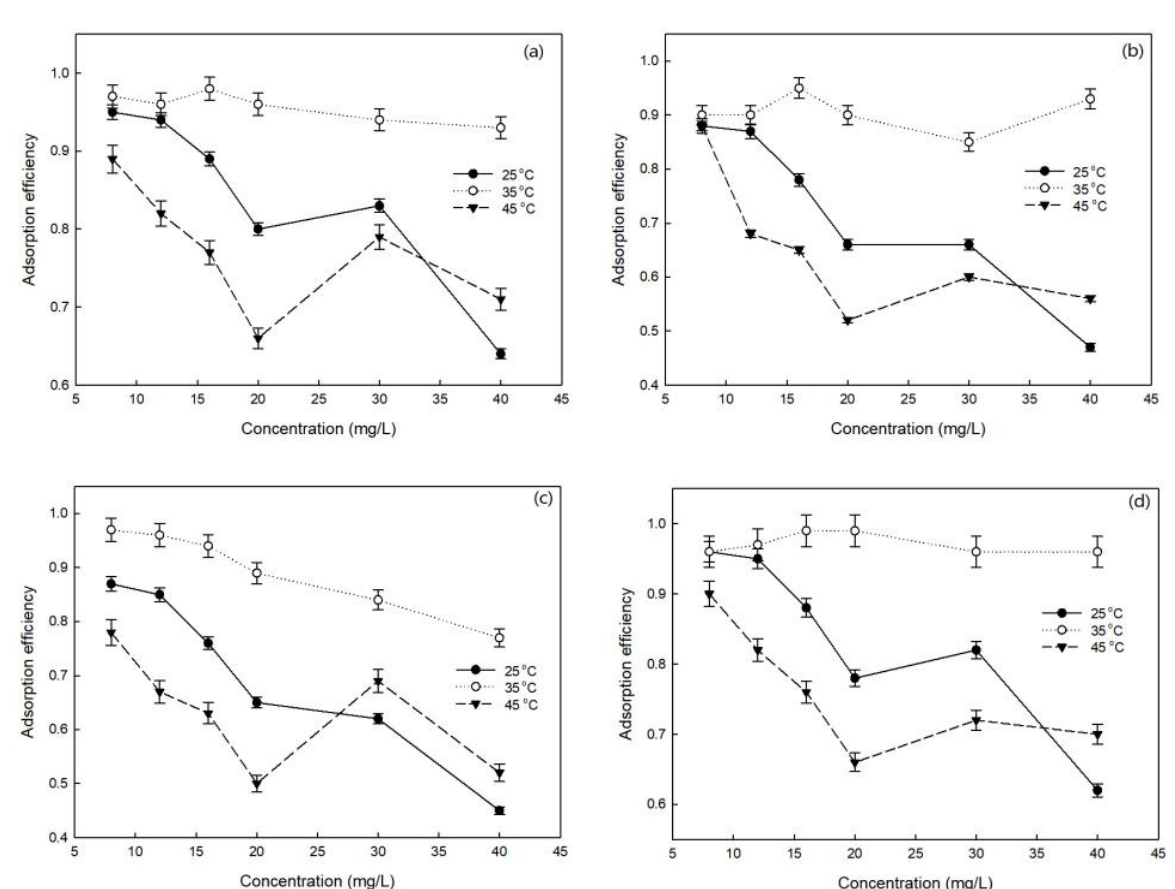
Figure 7: Adsorption isotherm of different antibiotics. (a) sulfamethoxazol; (b) thiazole; (c) methylpyrimidine; (d)